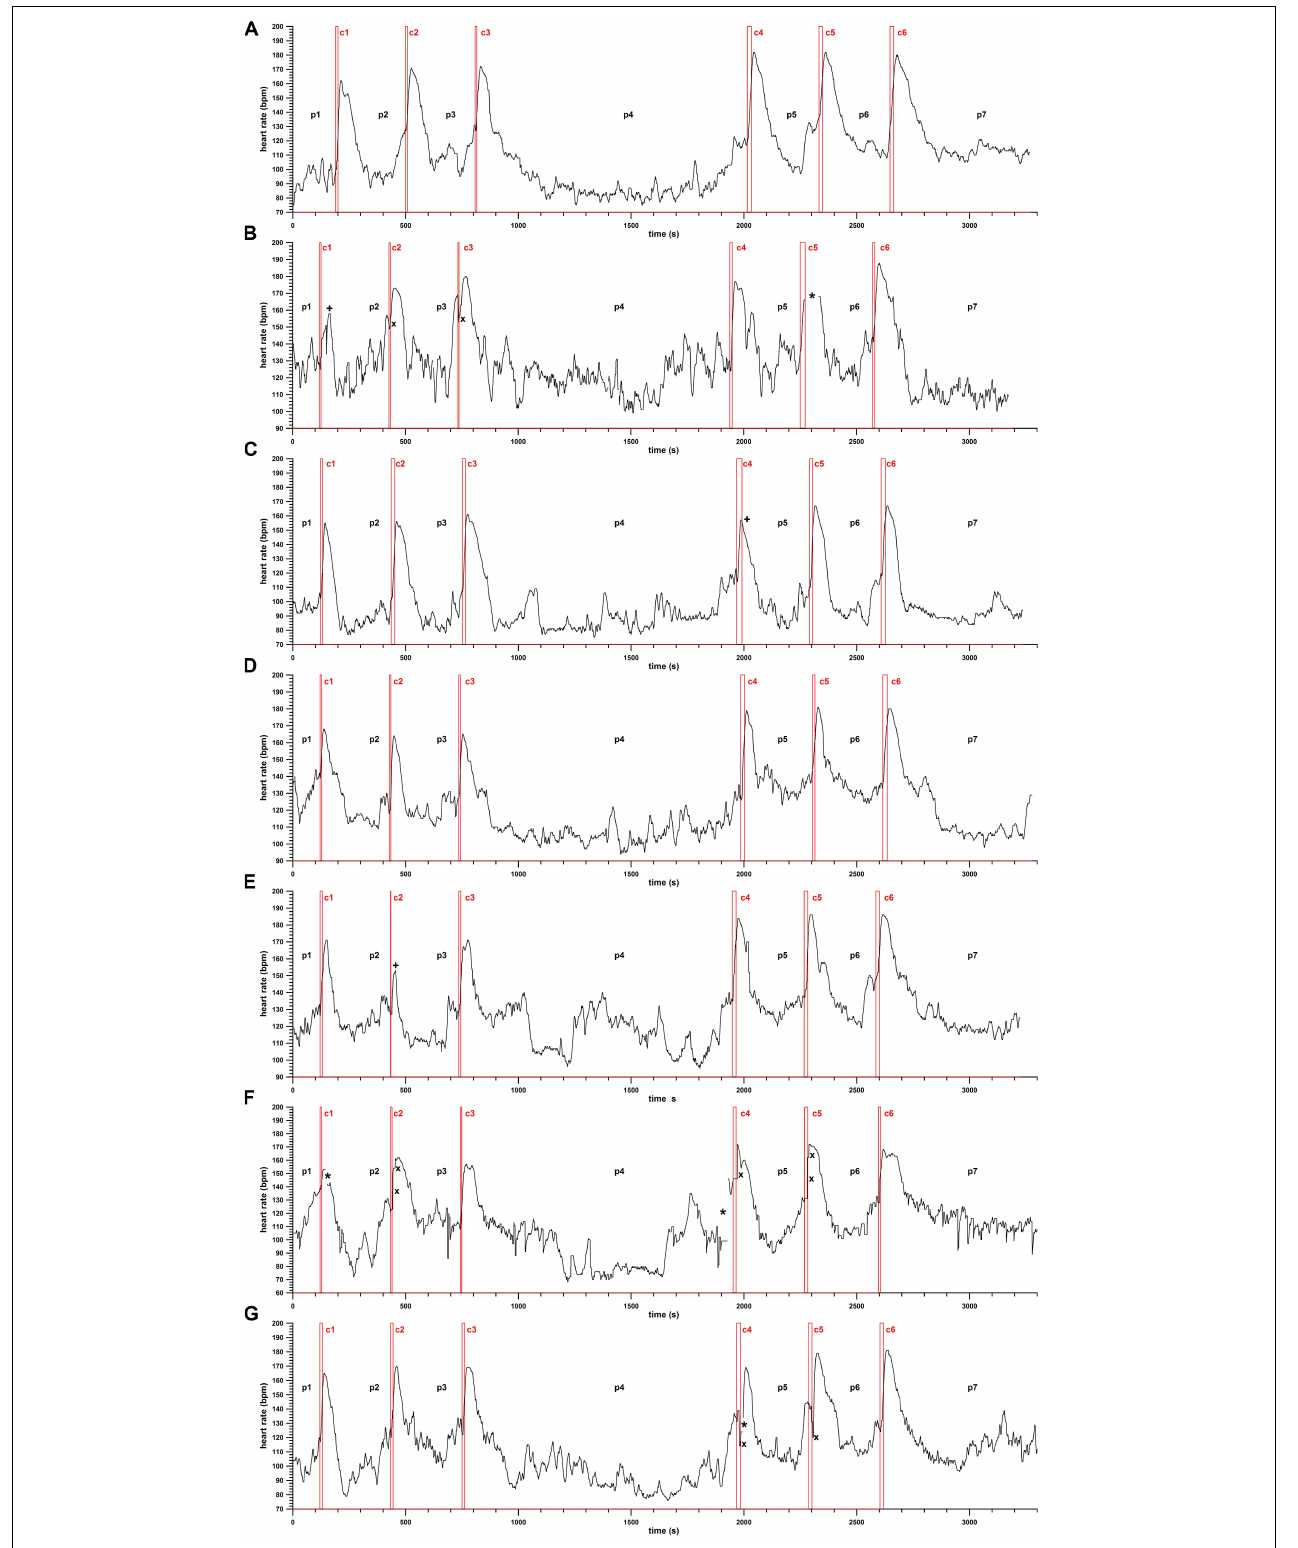
FIGURE 3 | Heart rate (HR; bpm) against time (s), HR profiles of climbers 1–7 (from top to bottom, A–G ); c1–c6, the six climbs per participant (c1–c3 = 10 m, c4–c46 = 15 m); p1–p7, pauses between the climbs; *, lost data; × , artifacts; +, unsuccessful climbs.